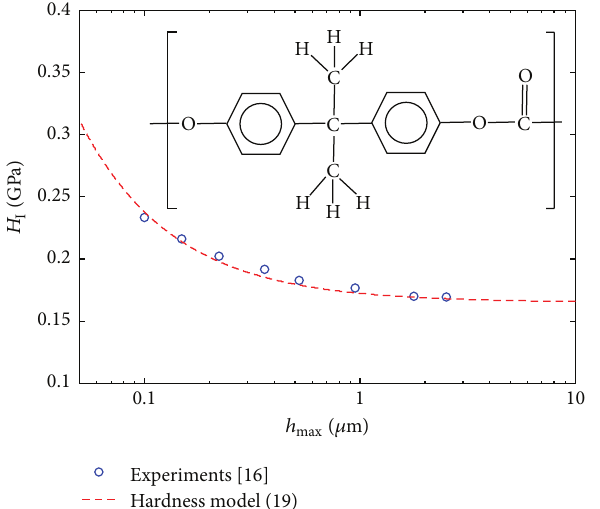
Figure 34: Indentation size effect of PA66 [39] and its molecular structure